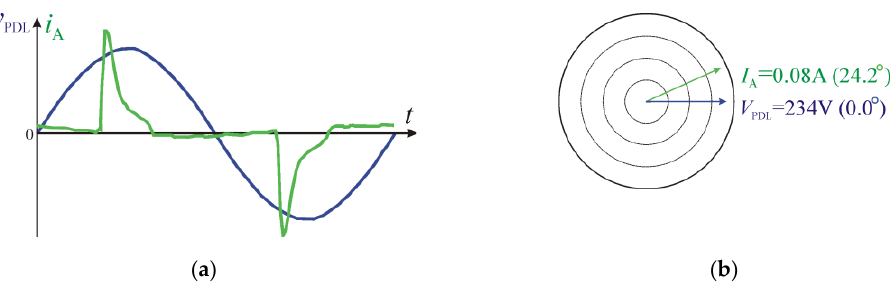
Figure A4. Experimental measurements at the point of connection 1850 lm 4000 K LED light bulb to PDL: ( a ) Voltage and current time diagrams; ( b ) Voltage and current phase diagrams defined for first harmonic.